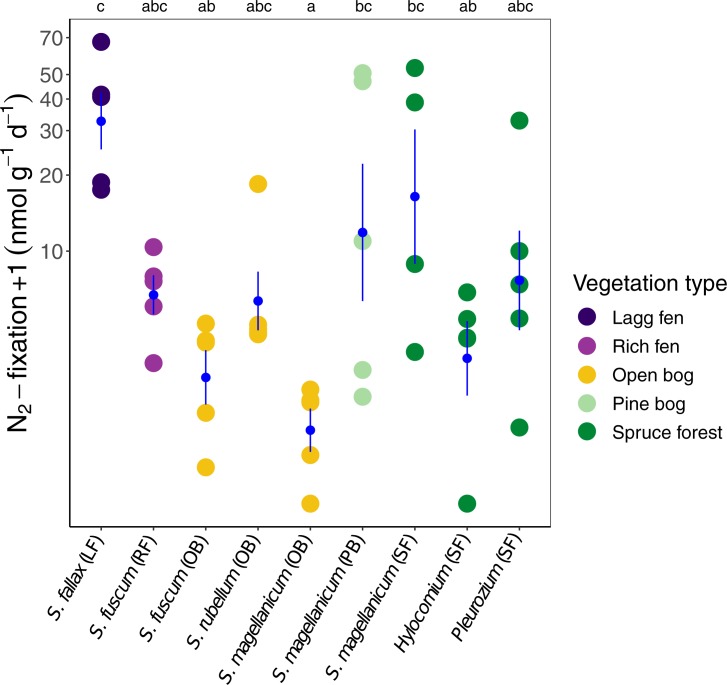
N2 fixation rates +1 on a logarithmic scale plotted for
Sphagnum and feather moss species and
habitats.Blue shows averages ± SEM (N = 5, except for S.
magellanicum (SF) with N = 4). Different letters
represent significant differences between species and habitats (based on
Tukey tests).